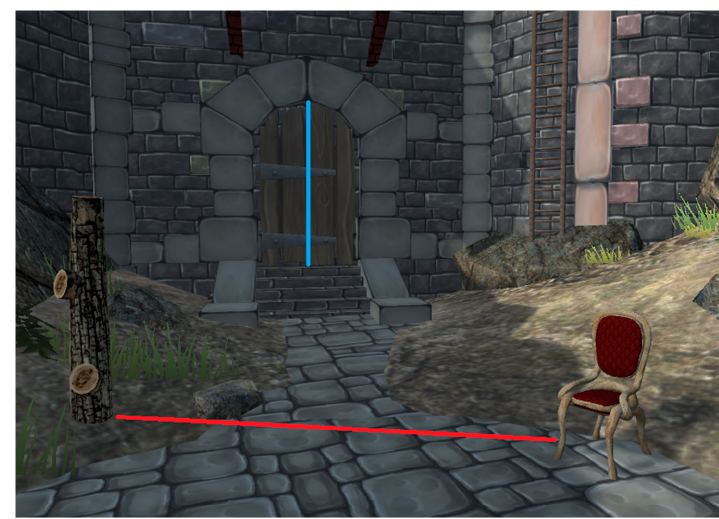
Figure 3. An example of spatial relations identification tasks as seen from the participant’s perspective; (red line—distance between the chair and the tree stump; blue line—height of the door).